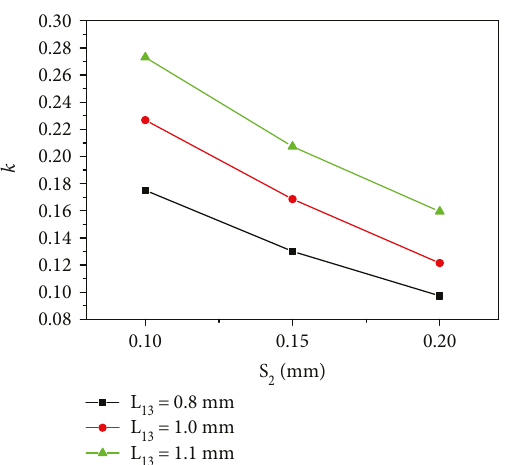
Figure 7: Coupling ratio with the value of S